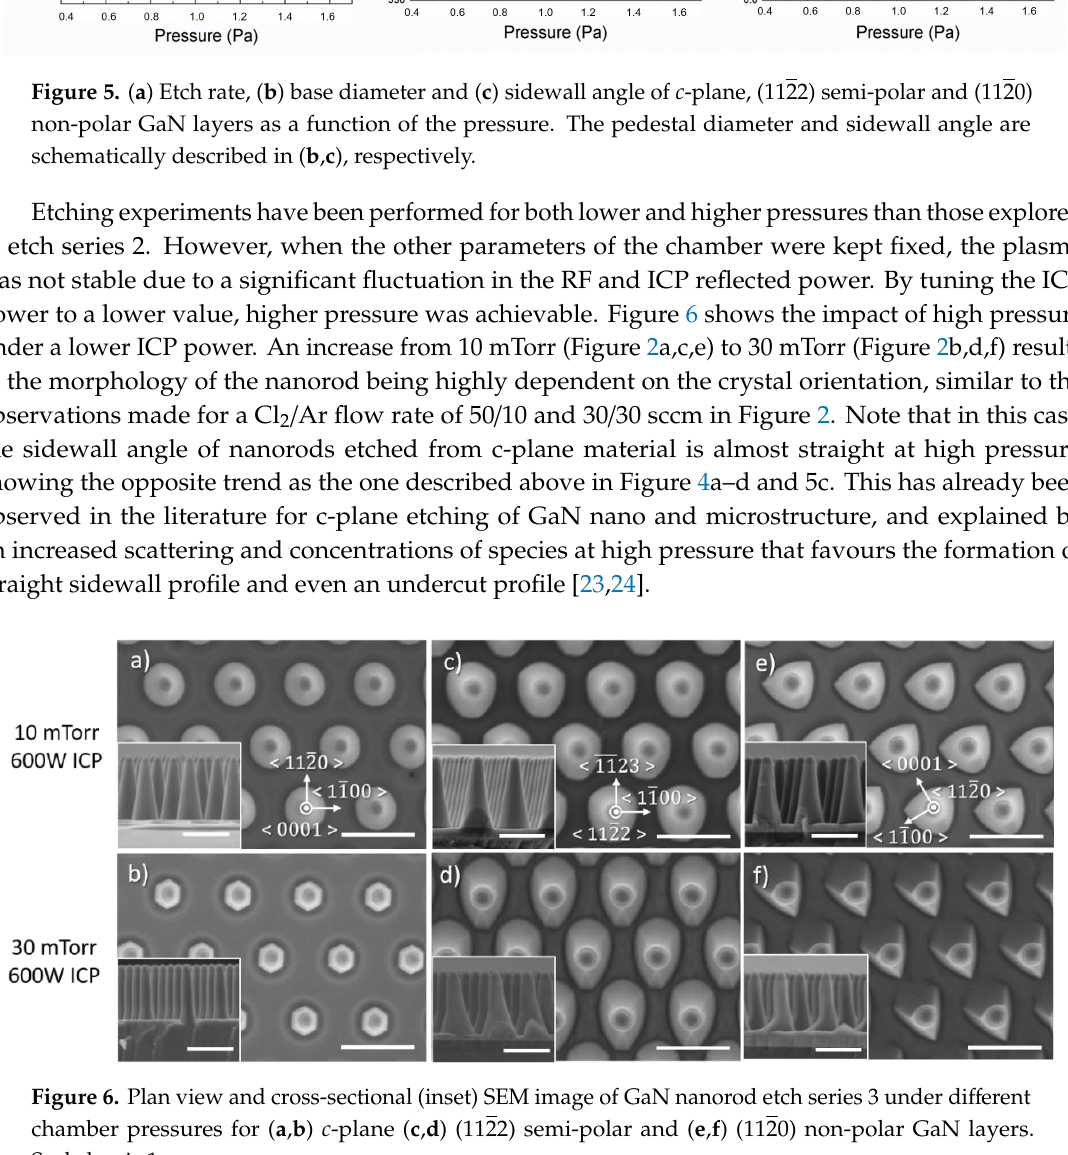
Figure 5. ( a ) Etch rate, ( b ) base diameter and ( c ) sidewall angle of c -plane, ( 112̅2 ) semi-polar and ( 112̅0 ) non-polar GaN layers as a function of the pressure. The pedestal diameter and sidewall angle are schematically described in ( b ) and ( c ), respectively.